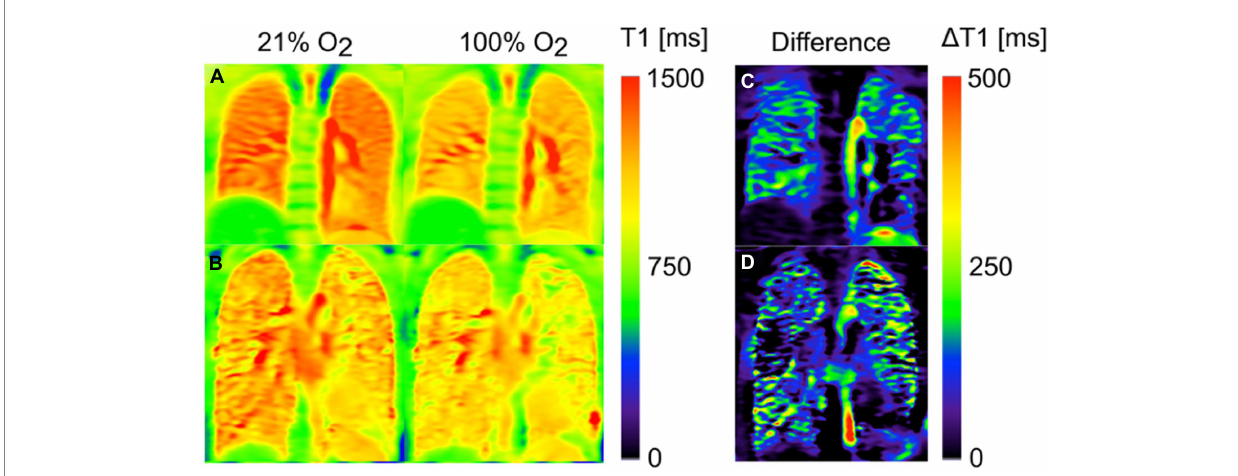
FIGURE 4 Oxygen-enhanced MRI T1 maps of a healthy volunteer (A) and a patient with cystic fibrosis (CF) (B) after inhalation of 21 and 100% oxygen. The third column shows the corresponding difference maps: While a homogenous reduction of T1(100% O2) in comparison with T1(21% O2) is found for the healthy volunteer (C) , some regions of the CF patient (D) show no or only small changes. Assuming that this effect can be mainly ascribed to reduced regional oxygen supply, the difference map can be interpreted as a surrogate for ventilation. Adapted with permission from